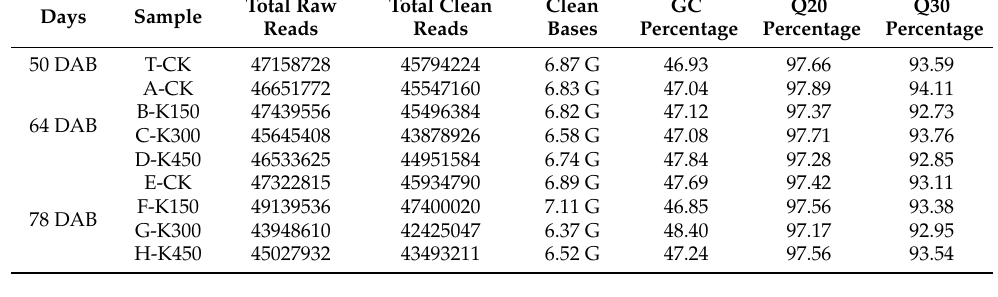
Table 5. Summary of sample sequencing data quality.